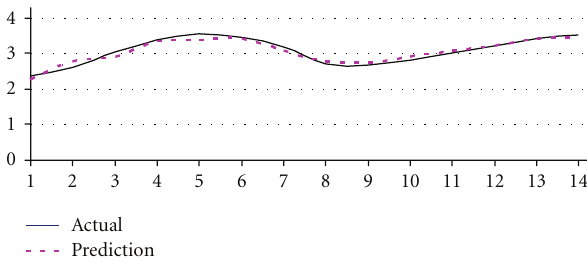
Figure 6: Proposed model prediction of lynx data (test